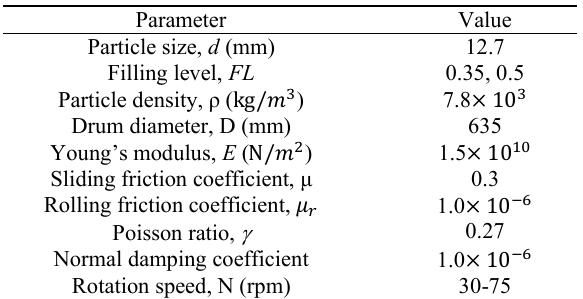
Table 2. Operation parameters in the simulation